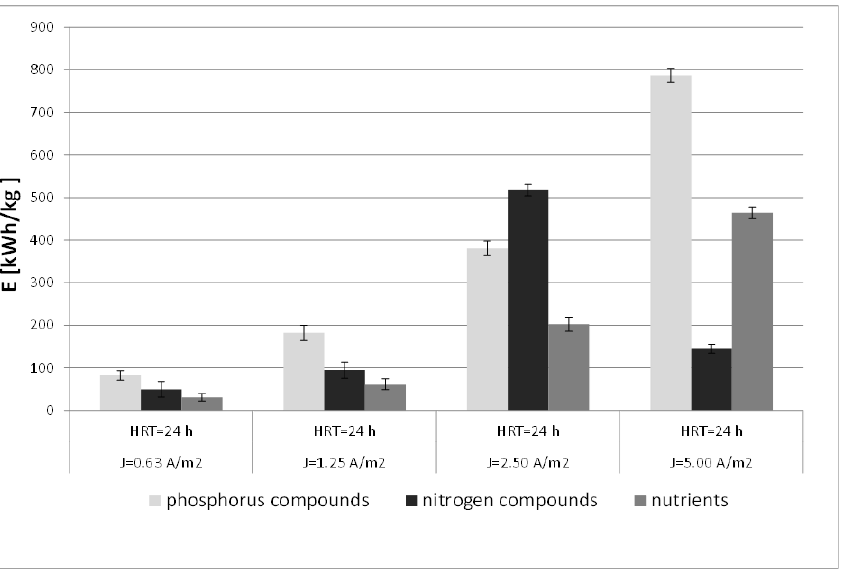
Figure 5. Electric energy consumption per unit of removed nutrient load in an anaerobic